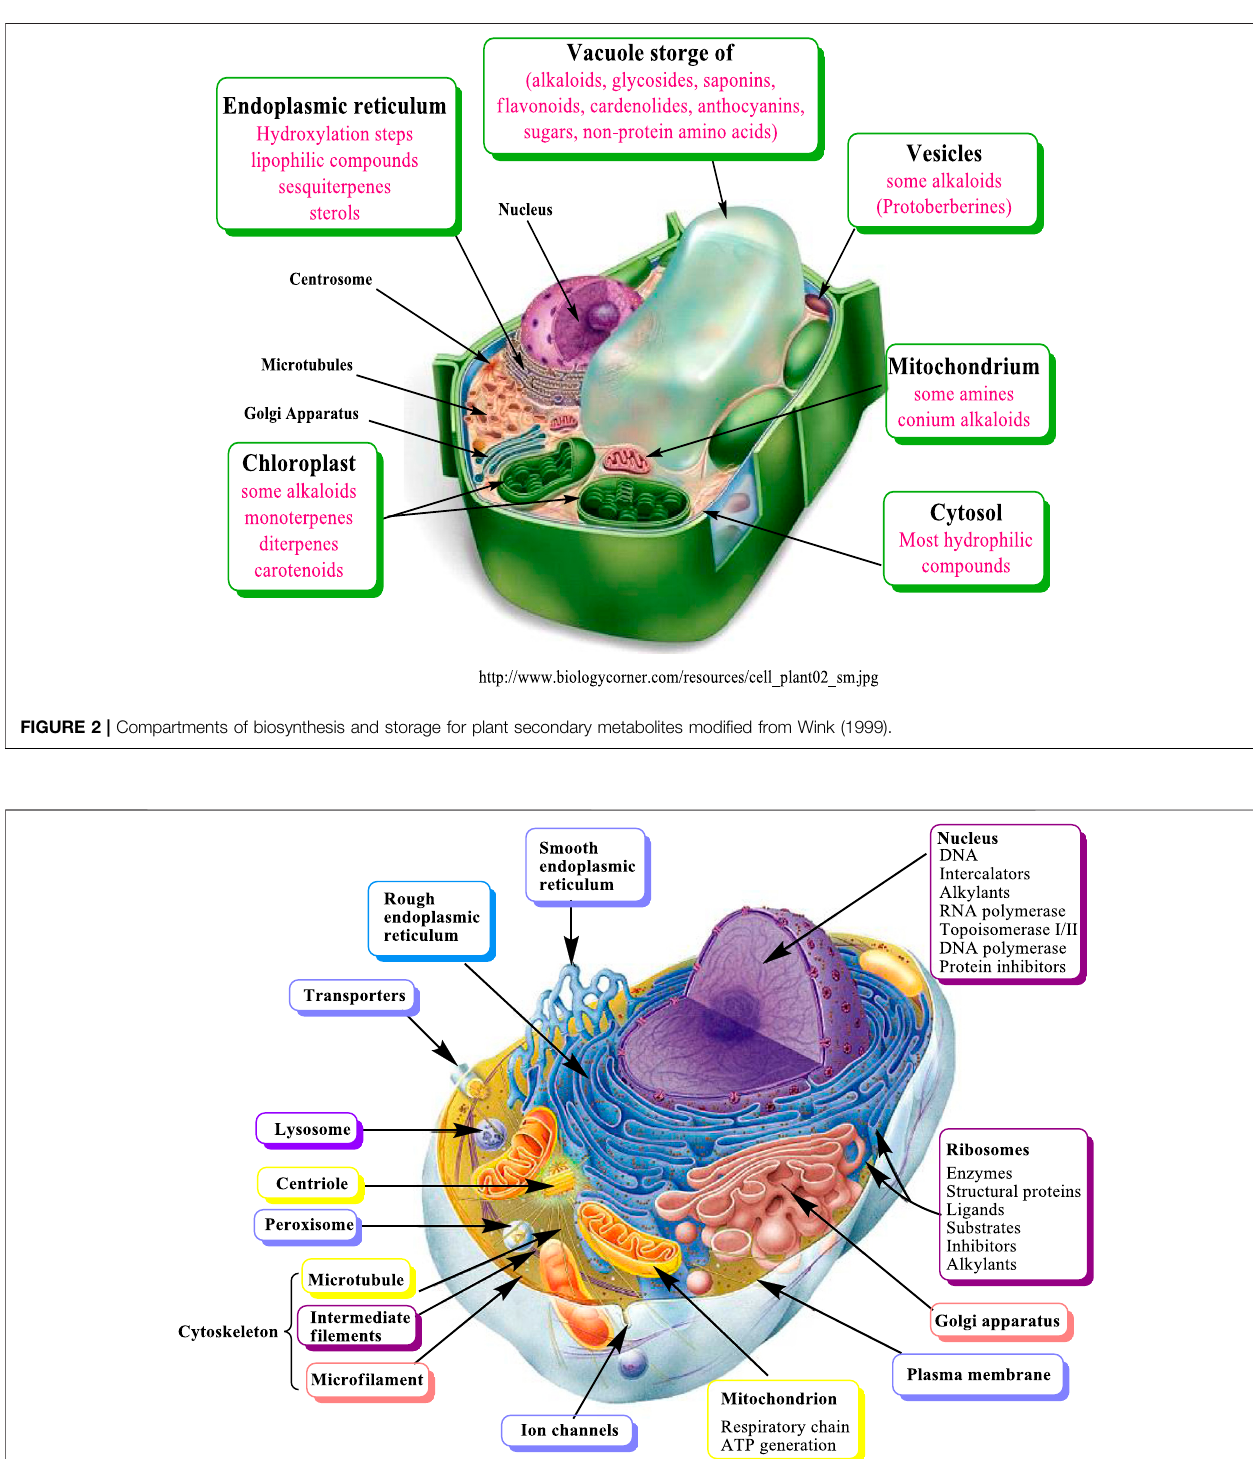
Frontiers in Pharmacology |